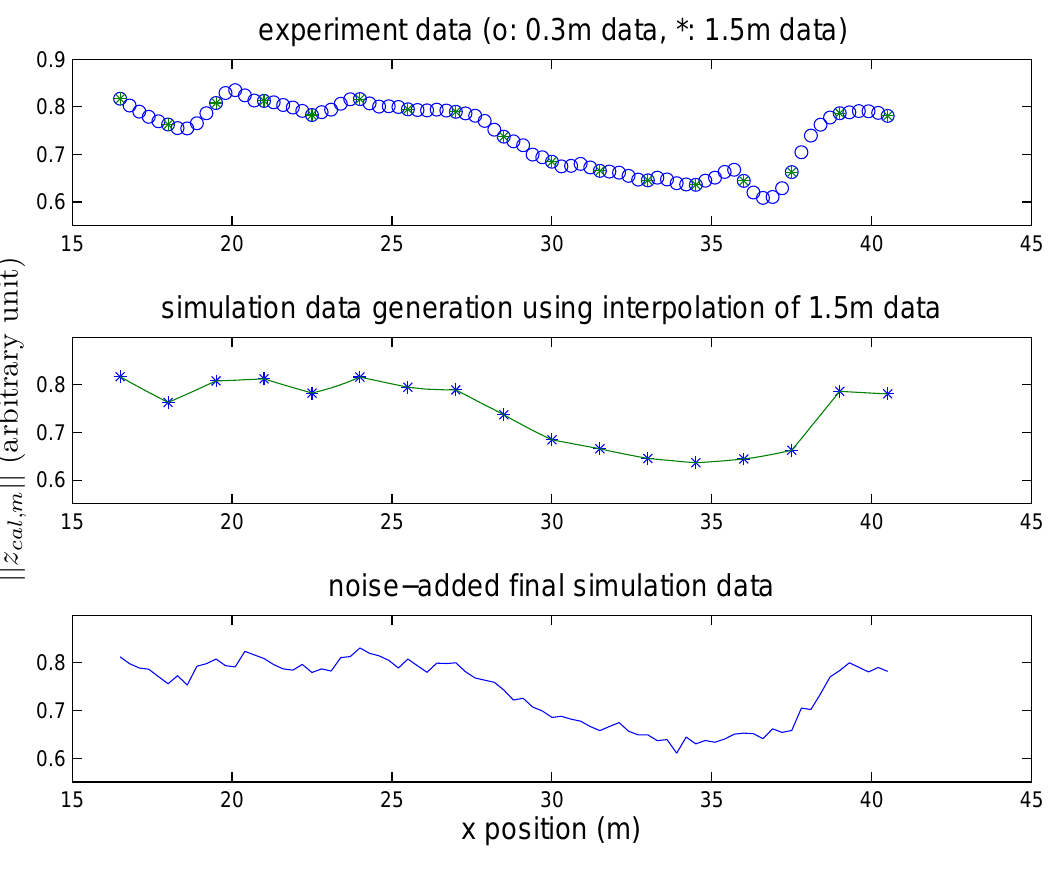
Simulation data generation example: (top) ∥ z experiment data, (middle) simulation data generation using interpolation of 1.5 m data (bottom) noise-added final simulation